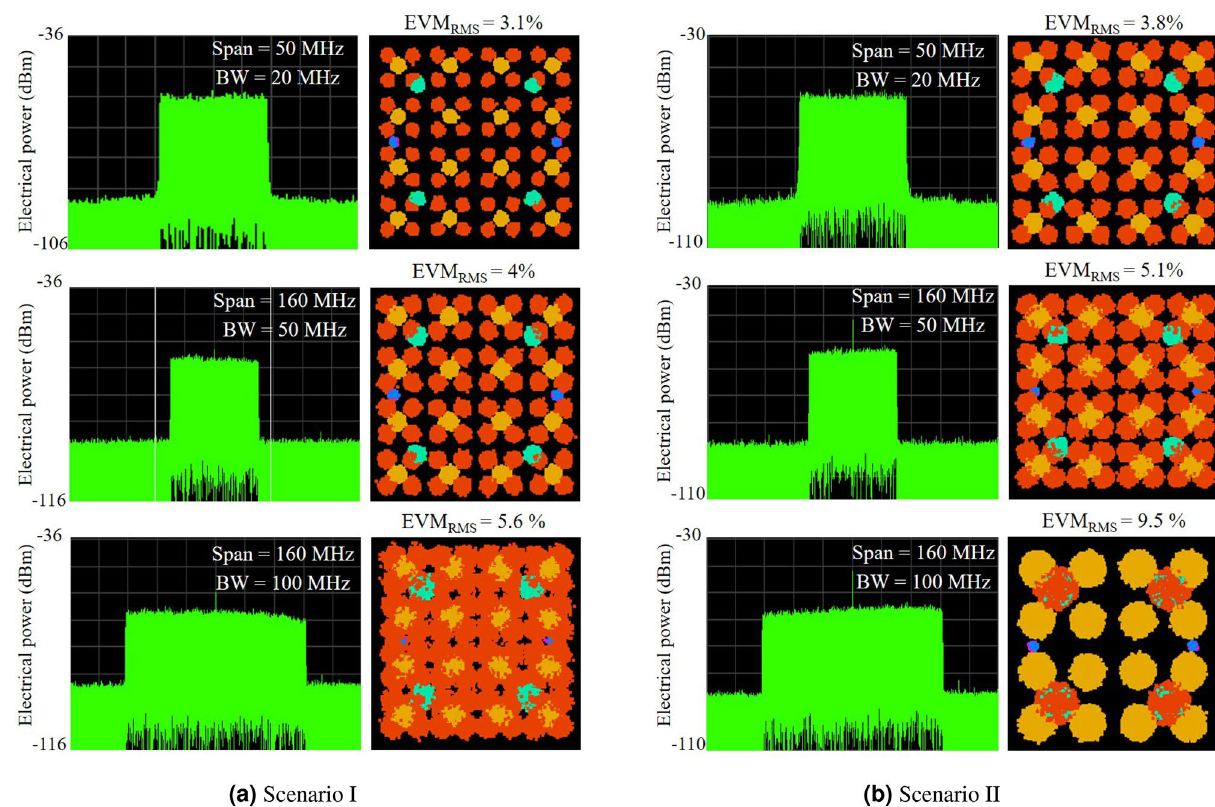
Figure 9. 5G NR access points performance evaluation for the Scenarios I and